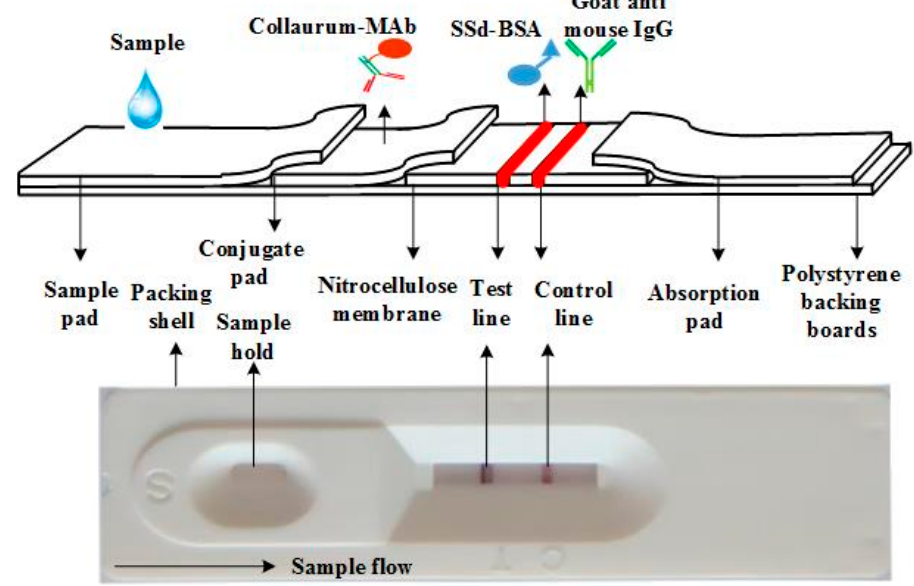
Figure 4. The structure and principle of the immunochromatographic strip (ICS). A nitrocellulose membrane, conjugate pad, sample pad, and absorbent pad were pasted onto a polyvinyl chloride backing to form the dipstick. Saikosaponin d (SSd)–bovine serum albumin (BSA) and goat anti-mouse IgG were used as the test capture reagent and control capture reagent, respectively. Using a dispenser, both the test and control capture reagents were dispensed separately as lines 0.5 cm apart on the nitrocellulose membrane.